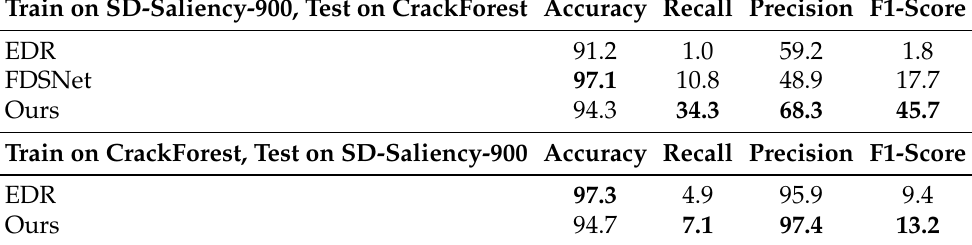
Figure 9. The results of training on SD-Saliency-900 and testing on CrackForest. Table 3. Quantitative pixel-level defect detection results on cross-domain dataset between EDR and ours. The best results are highlighted by bold fonts.